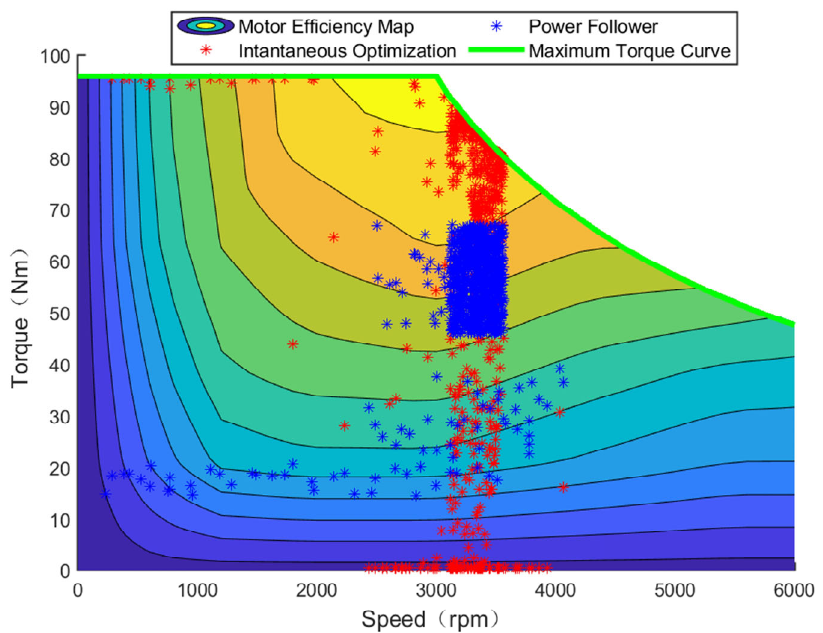
Figure 22. Motor operating points.